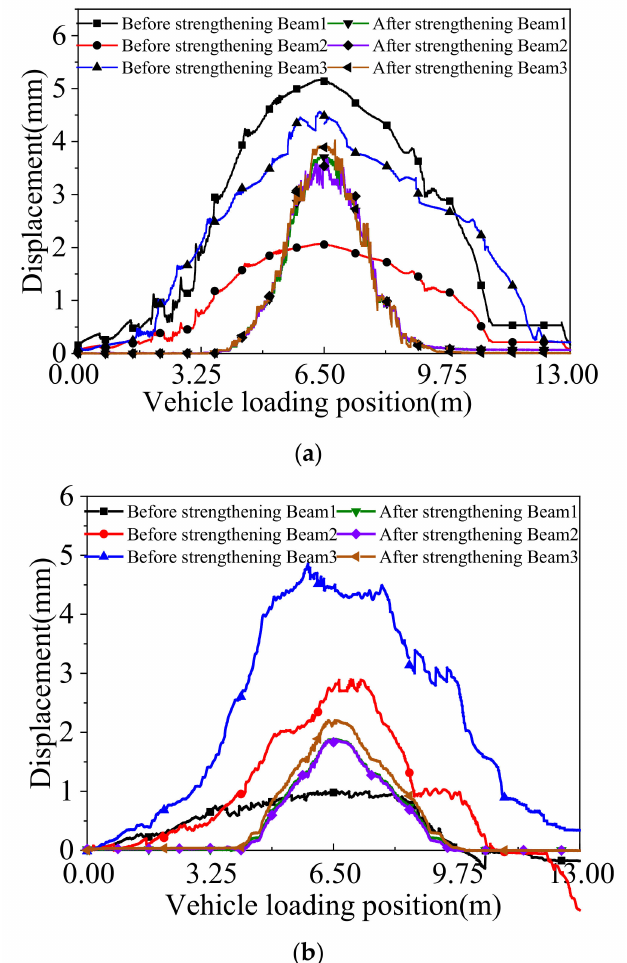
Figure 11. Deflections of the box girder at the mid-span under the continuous loading case. ( a ) Symmetrical loading. ( b ) Partial